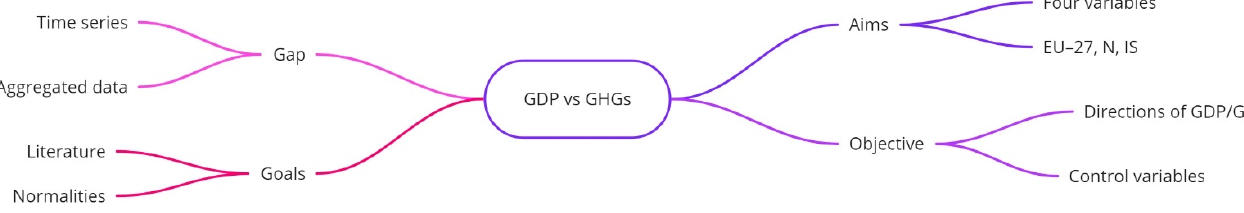
Figure 1. The research problem. Note: EU-27—27 European Union countries, N—Norway, IS— Iceland, GDP—GDP at constant prices, and GHG—air emissions accounting for greenhouse gases. Source: Authors’ compilation.